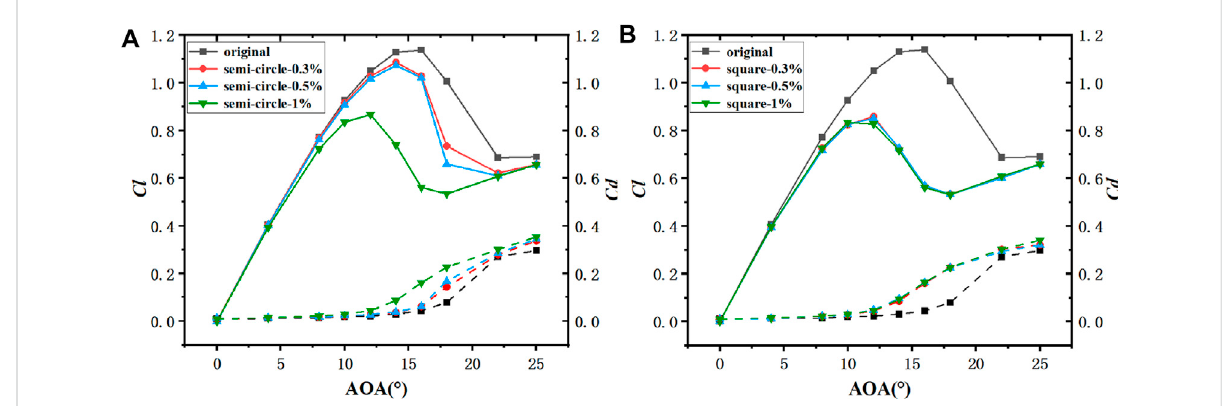
FIGURE 19 Comparison oftheLiftanddragcoef fi cientbetweentheoriginalairfoilandthesemi-circular/squareleadingedgeerosionairfoilforNACA0015. ( (A) : Semi-circular erosion airfoil; (B) : Square erosion